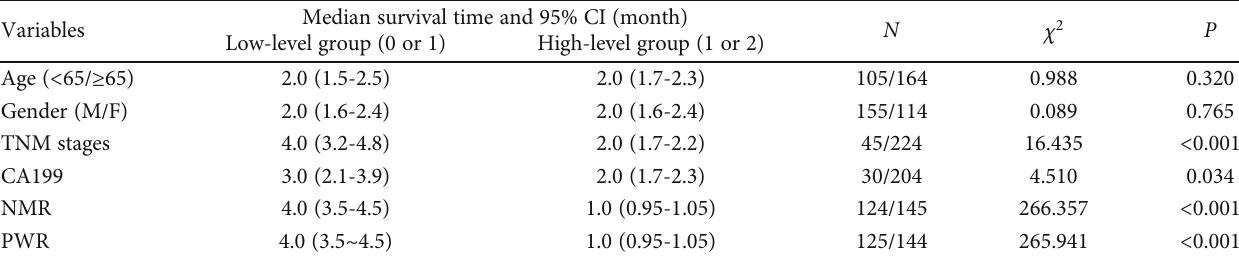
Table 5: Comparison of median survival time and 95% CI at di ff erent levels of